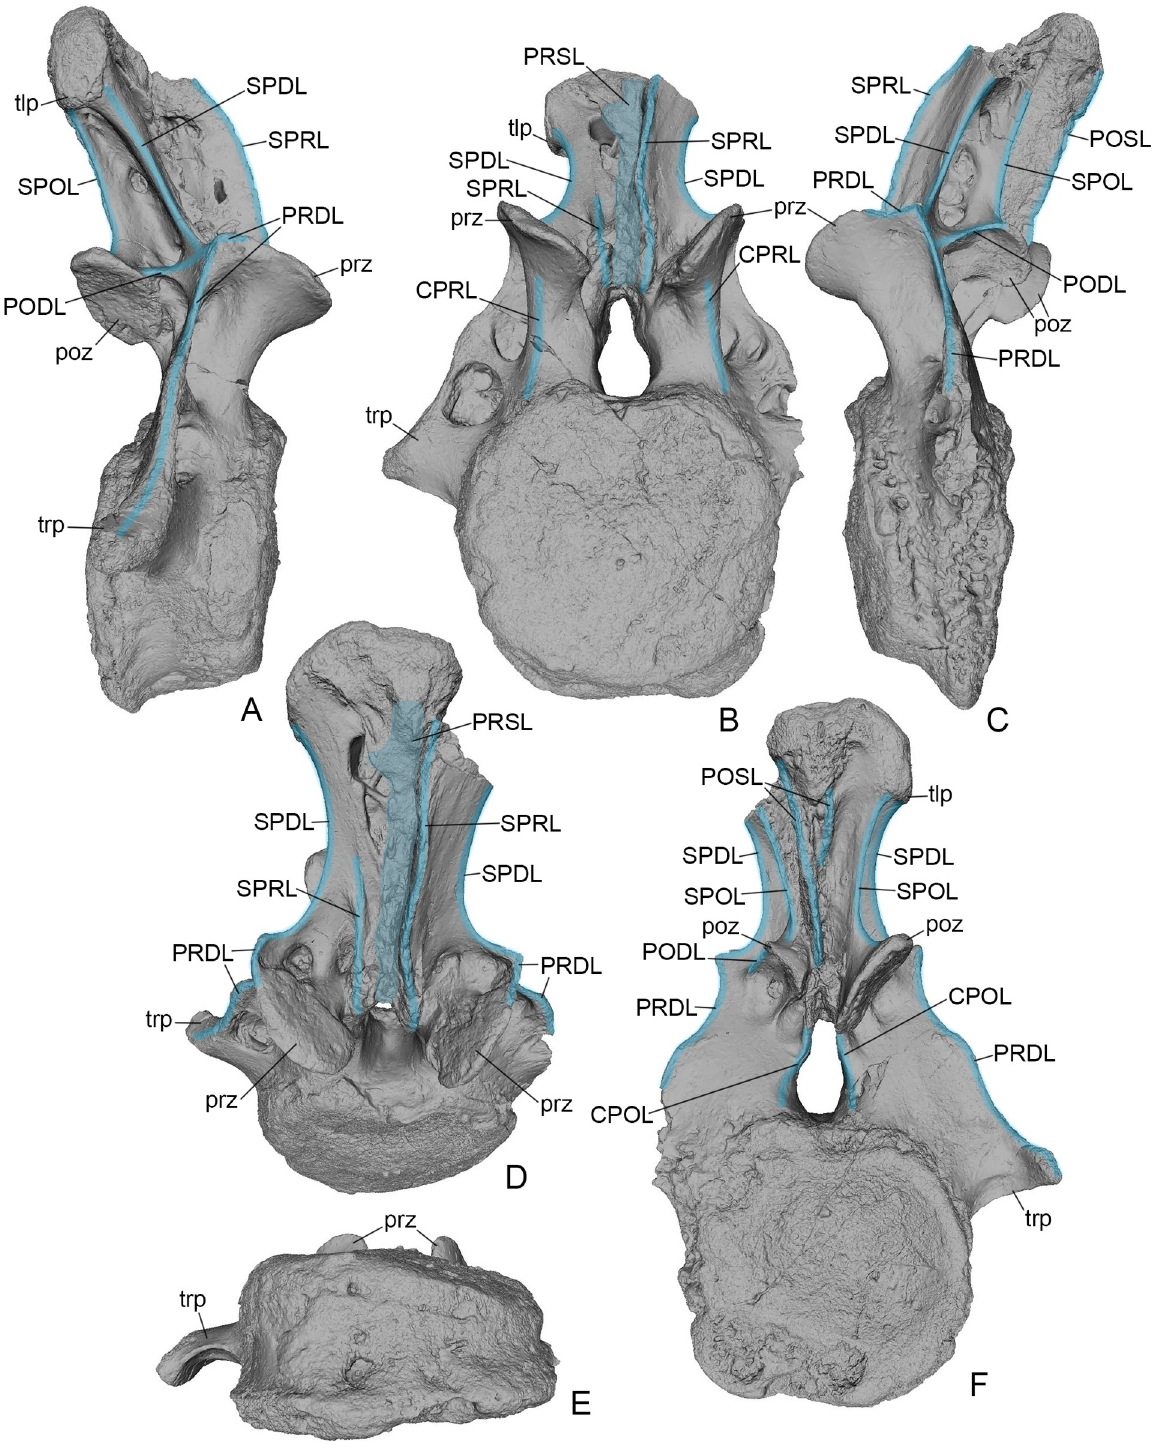
Fig 2. Dzharatitanis kingi , USNM 538133 (holotype), digital renderings of the anterior caudal vertebra in right lateral (A) , anterior (B) , left lateral (C) , anterodorsal (D) , ventral (E) , and posterior (F) views. The laminae are highlighted in blue. Abbreviations: CPOL, centropostzygapophyseal lamina; CPRL, centroprezygapophyseal laminae; PODL, postzygodiapophyseal lamina; POSL, postspinal lamina; poz, postzygapophysis; PRDL, prezygodiapophyseal lamina; PRSL, prespinal lamina; prz, prezygapophysis; SPDL, spinodiapophyseal lamina; SPOL, spinopostzygapophyseal lamina; SPRL, spinoprezygapophyseal lamina; tlp, triangular lateral process; trp, transverse process. Not to scale.